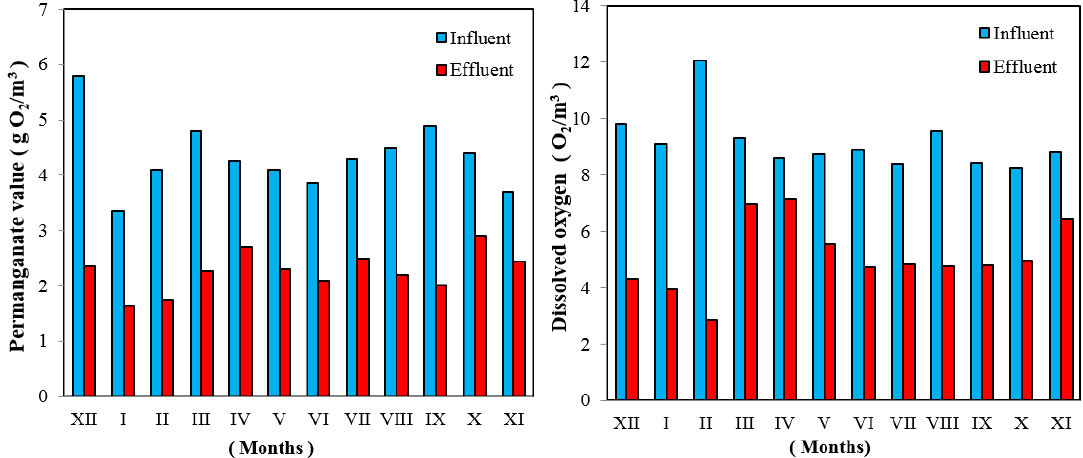
Figure 2. Average monthly values of total organic carbon and UV absorbance in water before and after the biofiltration process.